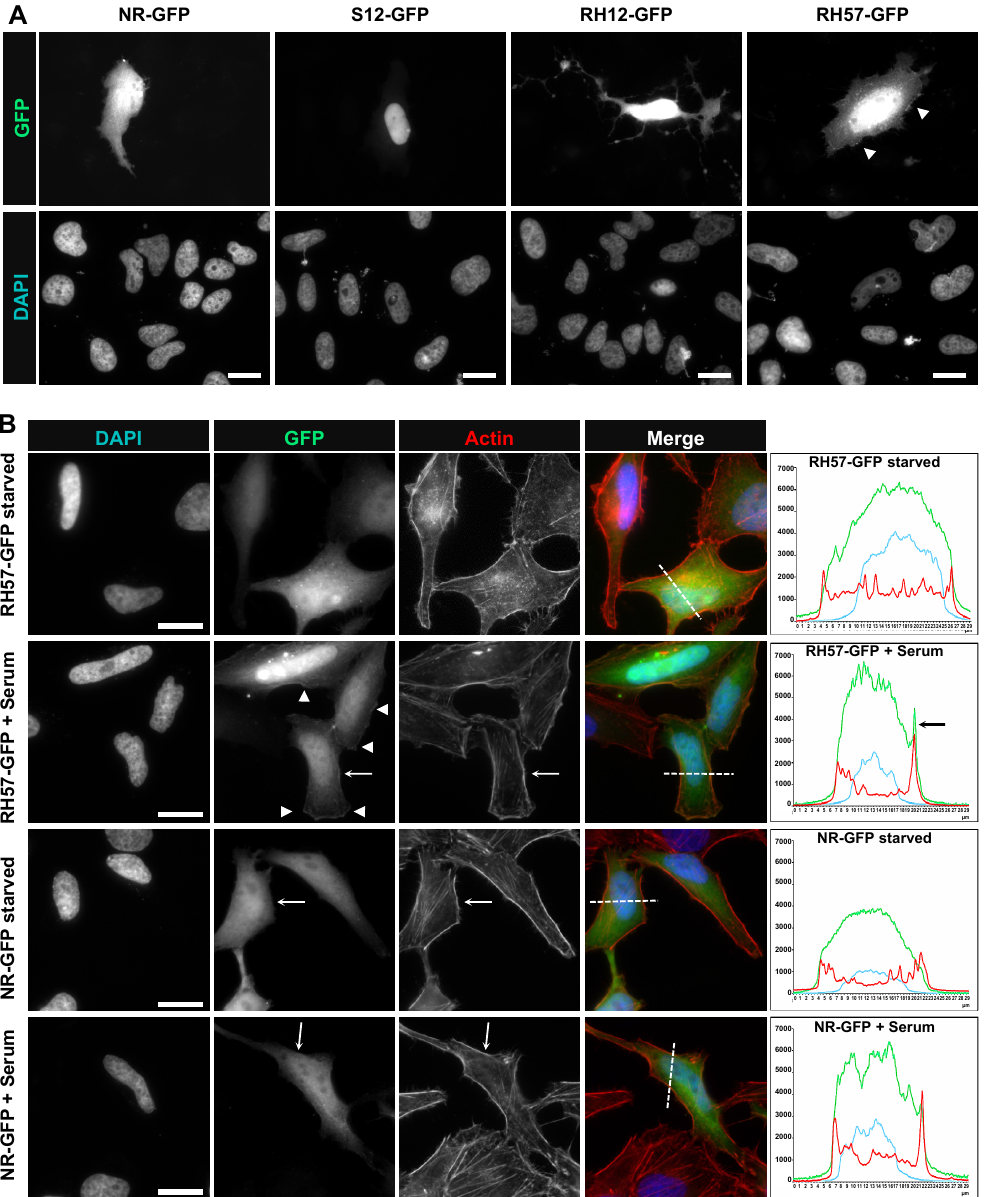
Figure 4. Chromobodies expression in HeLa cells. ( A ) Nanobodies NR, S12 (anti-Histone2A/B), RH12, and RH57 hs2dAb were fused to GFP and expressed in HeLa cells as chromobodies. While RH12 hs2dAb significantly alters cellular shape, potentially by interfering with RHO/RAC pathways, RH57 hs2dAb does not induce such a phenotype on HeLa cells. Arrowheads indicate areas of the plasma membrane with localized increased concentration of the chromobody (enlarged in Figure S1). The scale bars shown in the DAPI panels represent 20 µ m. ( B ) HeLa cells transfected with RH57-GFP or NR-GFP and serum starved for 24 h were stimulated with 20% serum to activate RHO GTPases. Arrowheads indicate areas of the plasma membrane with a localized increased concentration of chromobody RH57-GFP upon treatment (enlarged in Figure S2). Cut profile plots display the DAPI (blue), the GFP chromobody (green), and F-Actin (red) intensities corresponding to the dash line shown in the merge channel and arrows in GFP and actin staining channels. F-actin was stained with Alexa 568-Phalloidin. Co-localization of RH57-GFP pixels with F-actin is indicated by large arrows on the plot profile and the channels. Images are representative of transfected cells at moderate expression level. The scale bars shown in the DAPI panels represent 20 µ